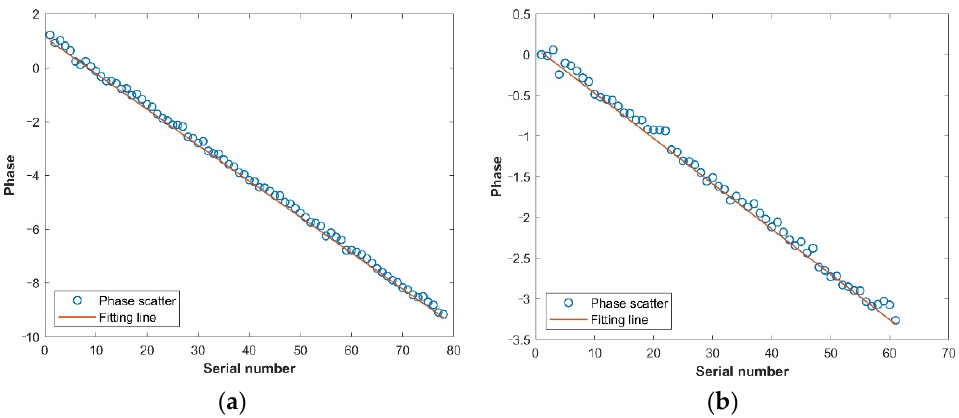
Figure 6. Straight-line fitting of left and right singular vectors, where ( a ) is the unwrapping phase and straight-line fitting result of left singular vector, and ( b ) is the unwrapping phase and straight- line fitting result of right singular vector.